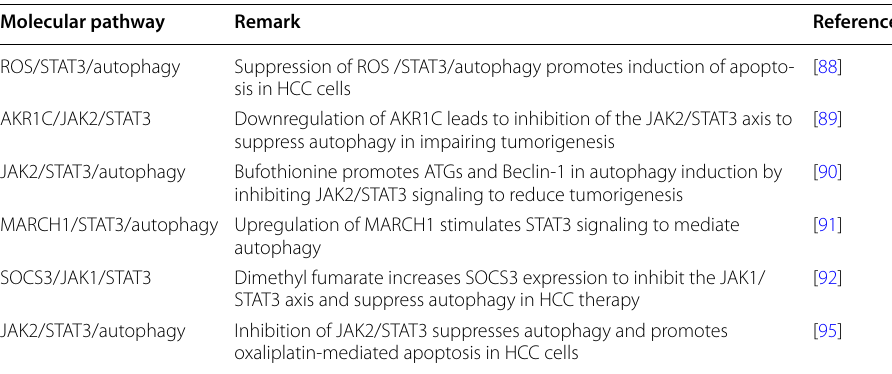
Table 1 The role of STAT3 in regulating autophagy in HCC Molecular